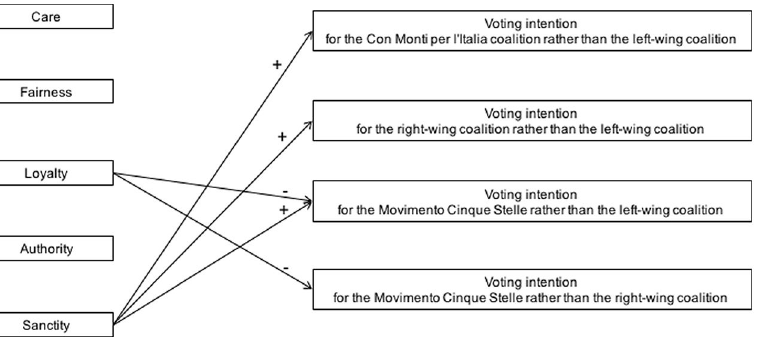
Figure 4. The association between distinct moral foundations and voting intention in 2013 Italian national elections, Study 3. Visualization of the main results obtained in regression analyses, controlling for ideological